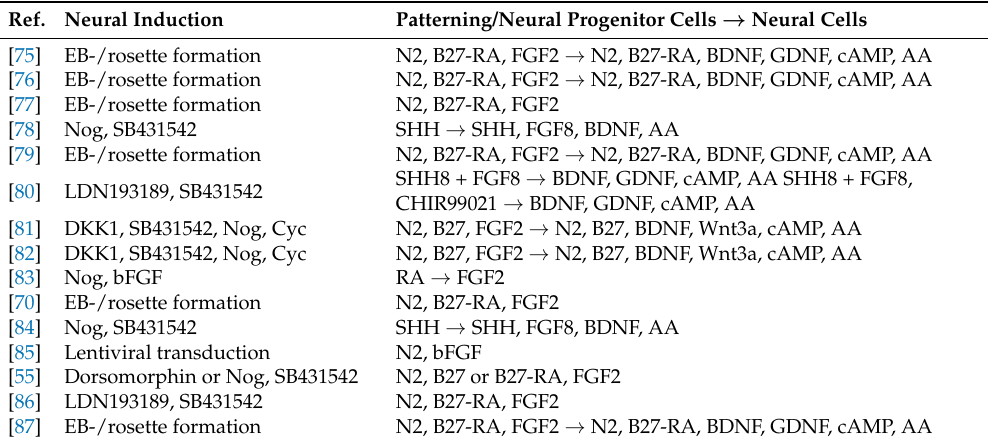
Table 3. Major differentiation